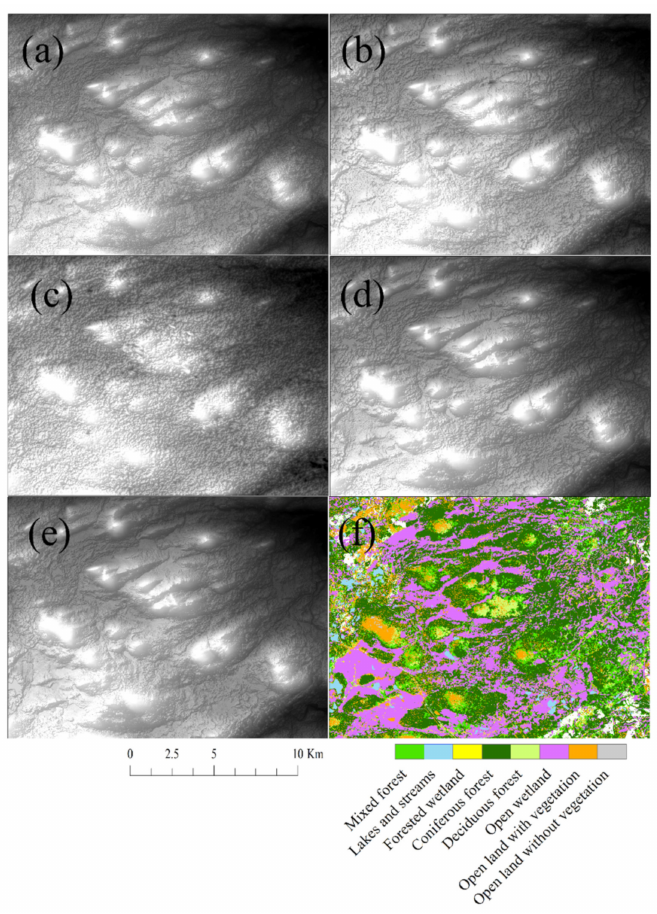
Figure 2. Subsets of reference DEM ( a ), Arctic DEM ( b ), ALOS ( c ), ASTER ( d ), Copernicus ( e ) and the National Land Cover map (extent shown in Supplementary Figure S1). ( f ) The horizontal legend refers to the landform classes in ( a – e ), while the vertical legend refers to the land cover classes in ( f